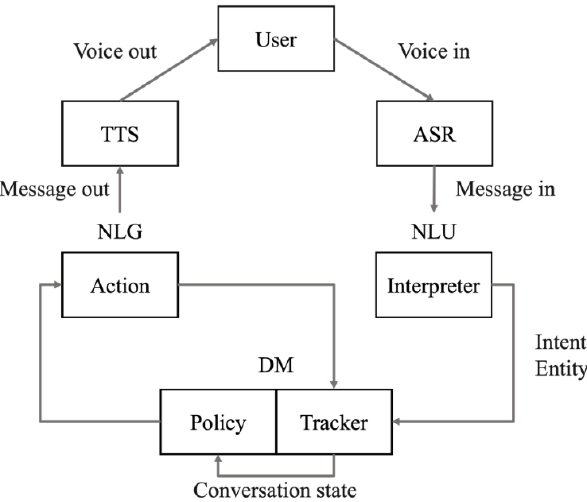
Figure 3. Architecture and process of the chatbot modules.